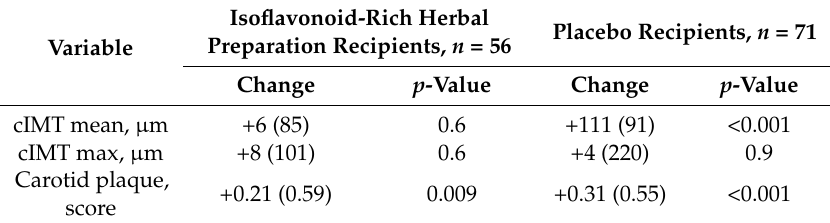
Table 3. Carotid atherosclerosis progression.